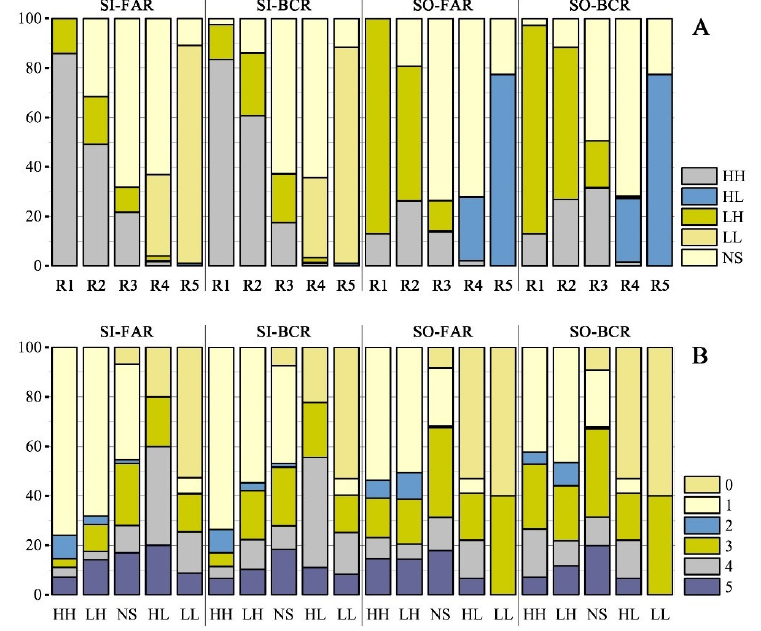
Figure 6. ( A ) The proportion of LISA results in each ring road, R1–R5 are different urban ring road enclosures. ( B ) The proportion of each land type in LISA results, 0–6 are land use types, see Table 3 for specific explanations.